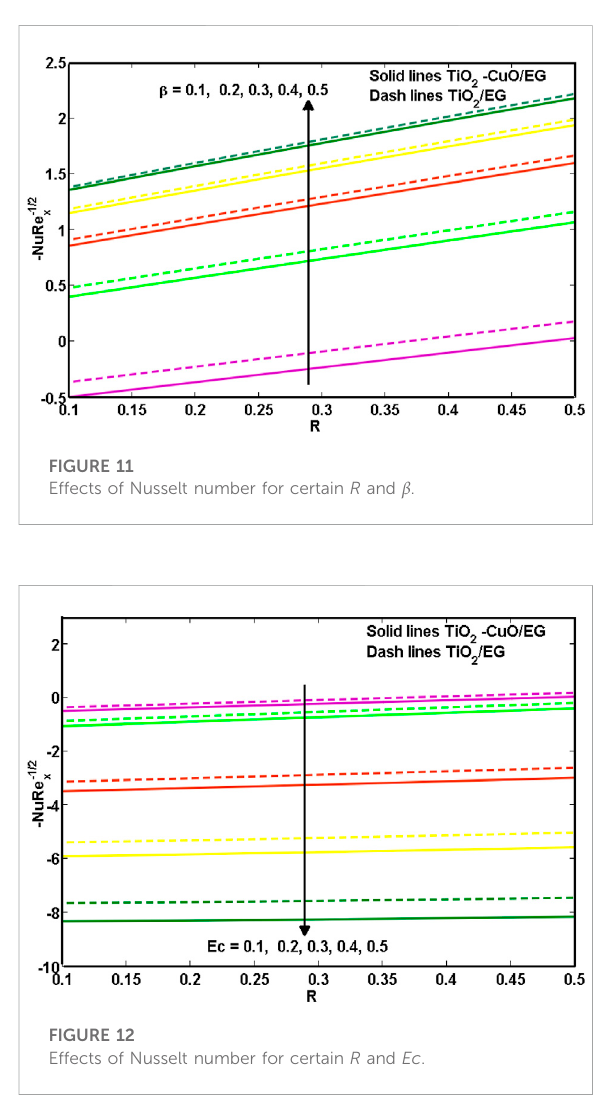
FIGURE 12 Effects of Nusselt number for certain R and Ec .